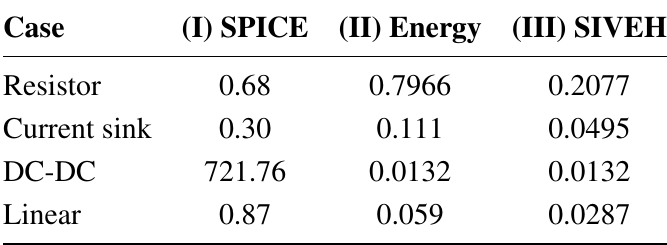
Table 2. Execution time (in seconds) of SPICE, the numerical energy model and SIVEH to simulate a supercapacitor complete discharge process (initial conditions: R = 100 Ω ; I = 10 mA; ∆ t = 1 ms; C = 10 mF; V sink linear